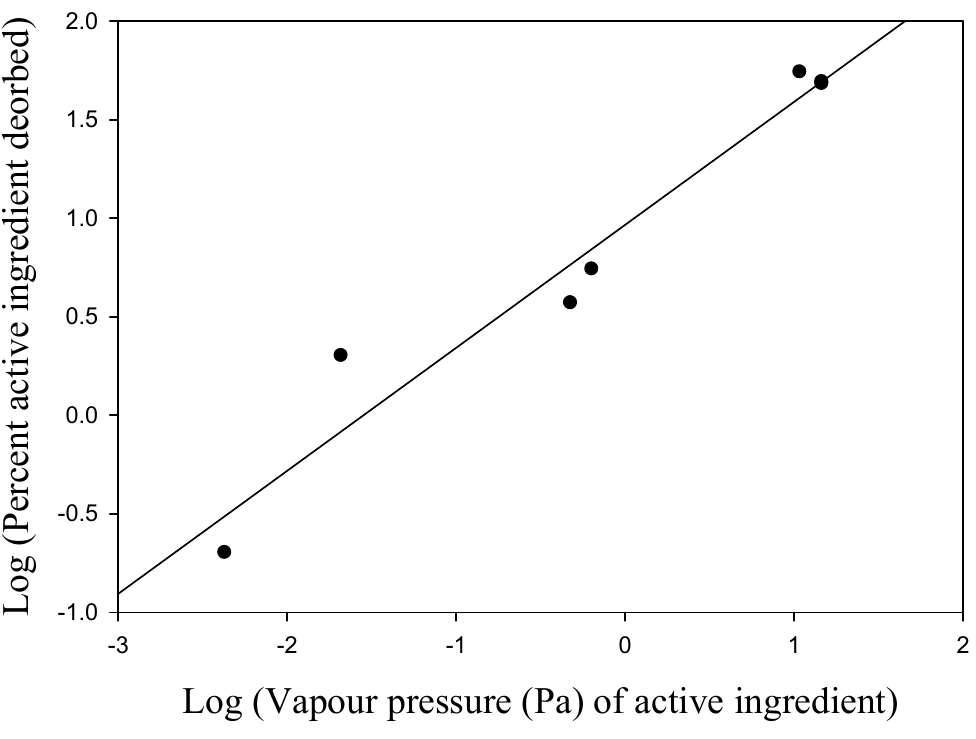
Figure 1. Plot of percent active ingredient desorbed versus active ingredient vapour pressure -transformed values. Values shown are for the three using Log 10 preemergence-applied (trifluralin, triallate, ethalfluralin) and four postemergence-applied (bromoxynil octanoate, diclofop methyl ester, 2,4-D 2-ethylhexyl ester, fenoxaprop ethyl ester) active